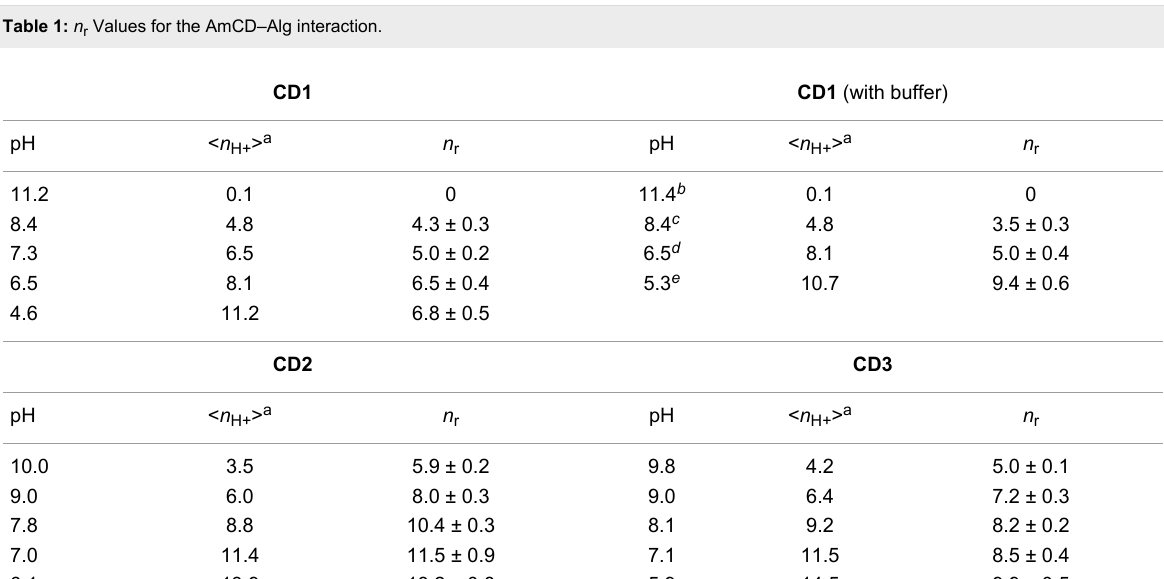
made at pH 8.4 revealed the presence of a very small popula- tion of objects having an average diameter of 450 ± 150